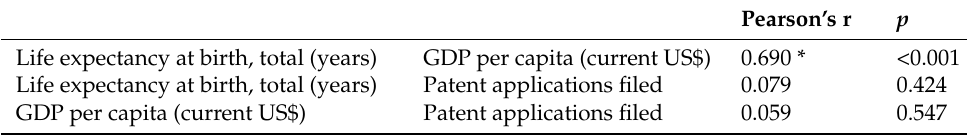
Table 4. Pearson’s Correlations.